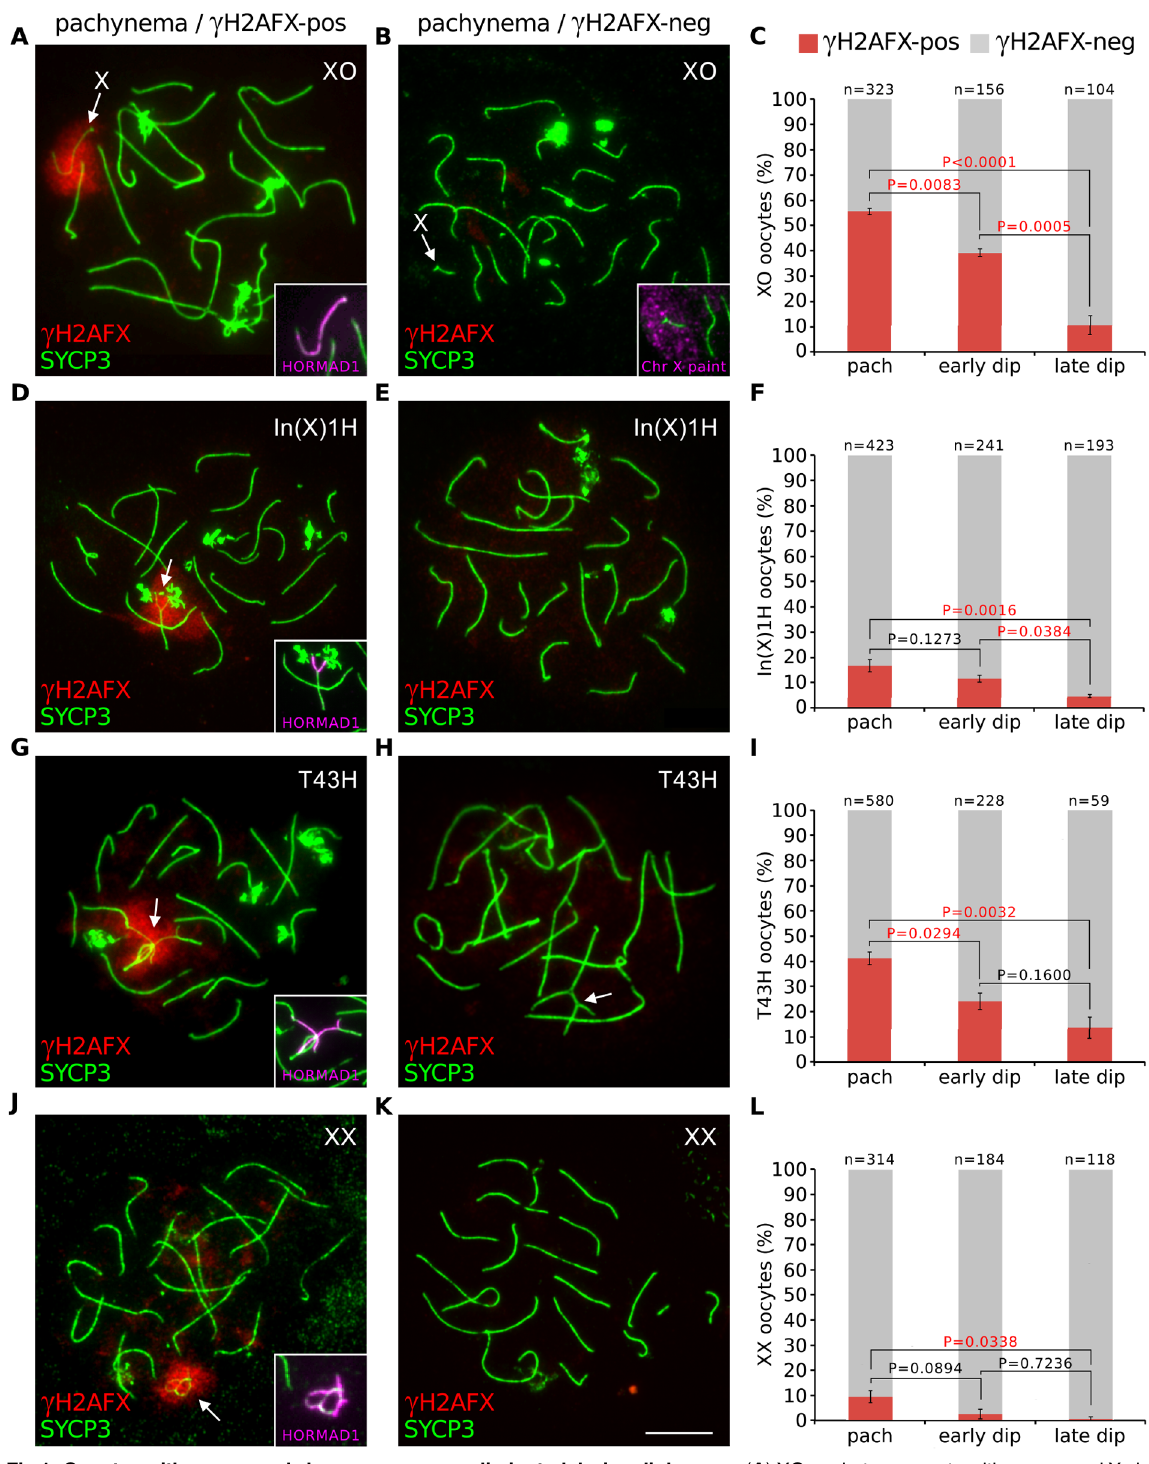
Fig 1. Oocytes with asynapsed chromosomes are eliminated during diplonema. ( A ) XO pachytene oocyte with asynapsed X chromosome (arrow). SYCP3 (green) marks chromosome axes, γ H2AFX (red) marks chromatin associated with asynapsed axes, and HORMAD1 (magenta, insets) marks asynapsed axes. ( B ) XO pachytene oocyte with self-synapsed X chromosome. The self-synapsed X chromosome (arrow) was identified by X chromosome painting (magenta, inset). ( C ) The mean percentage ( ± s.e.m.) of XO oocytes with a γ H2AFX-positive or γ H2AFX-negative X chromosome at pachynema, early diplonema and late diplonema. ( D ) In(X)1H pachytene oocyte with asynapsis (arrow). ( E ) In(X)1H pachytene oocyte with fully synapsed chromosomes.